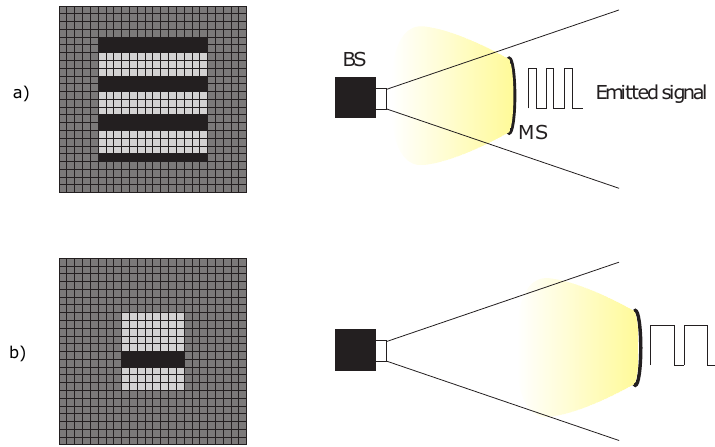
Figure 8. Example of detected OCC signal. ( a ) A closer object would blink at a higher frequency, and its projected image would be large. ( b ) A further object would be projected in a smaller ROI and the period of the transmitted signal would